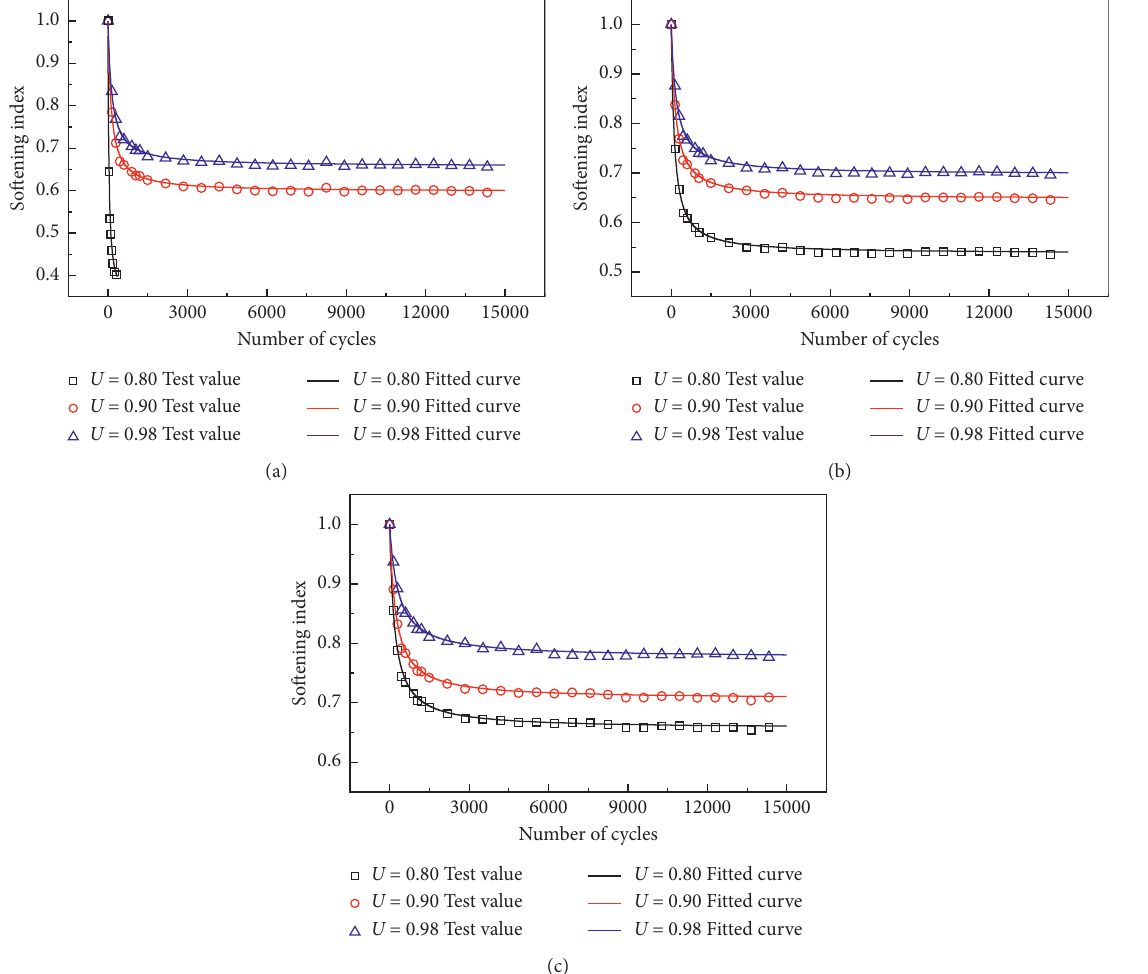
Figure 14: The fitting value of the development of the softening index under different degrees of consolidation: (a) P � 20% and σ ′ � 100kPa; (b) P � 20% and σ 3